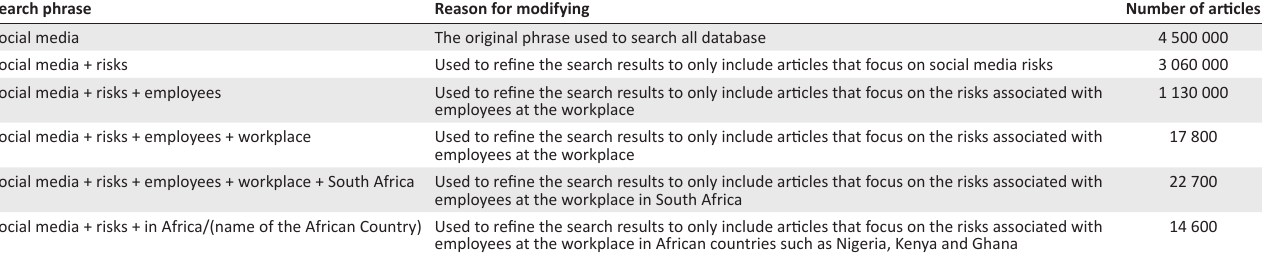
TABLE 1: Keywords used for the database extract after Boell and Cecez-Kecmanovic. 26 Search phrase